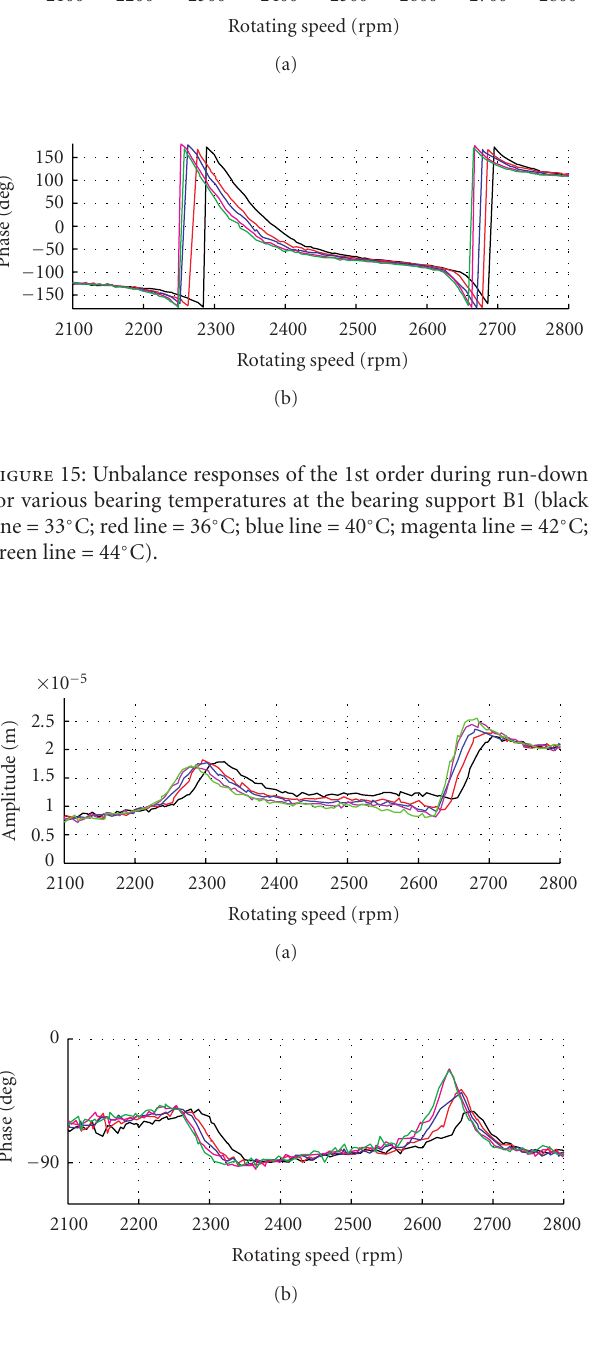
Figure 16: Unbalance responses of the 1st order during run-down for various bearing temperatures at the plane location A3 (black line = 33 ◦ C; red line = 36 ◦ C; blue line = 40 ◦ C; magenta line = 42 ◦ C; green line = 44 ◦ C).